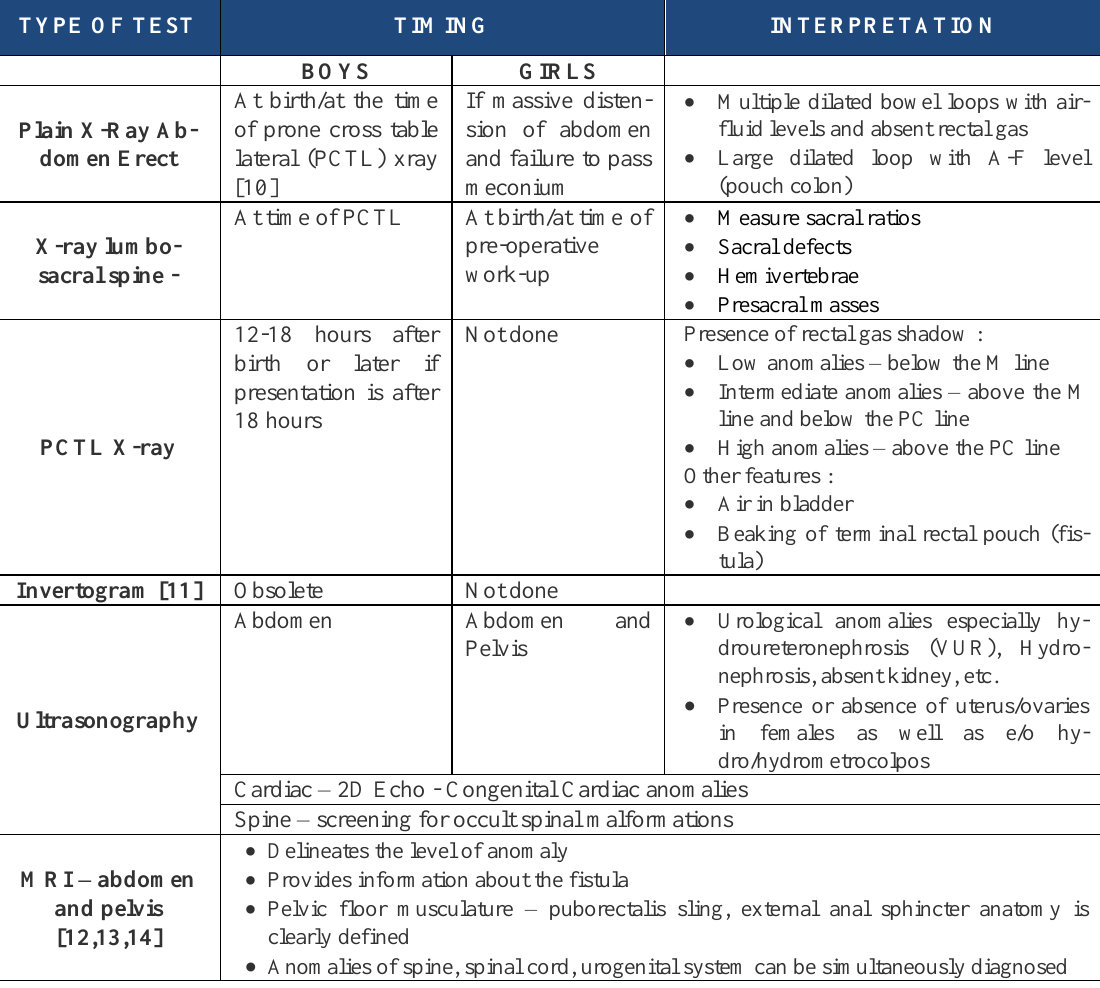
Table 6: Radiological assessment in newborns with Anorectal malformations TYPE OF